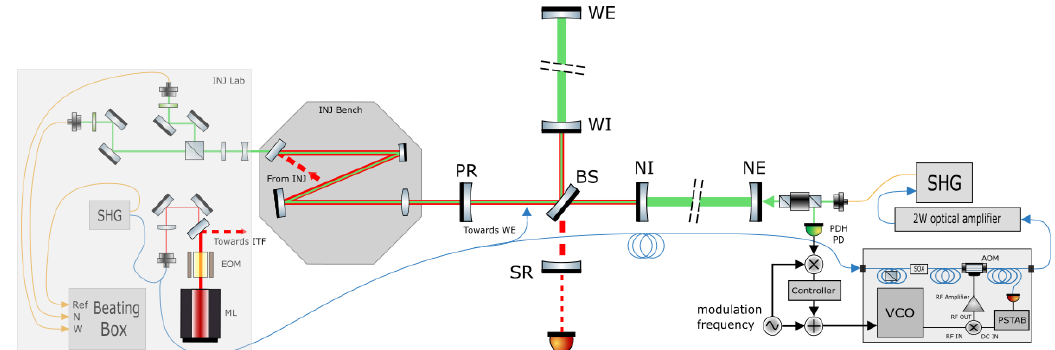
Figure 2. General scheme of the Auxiliary Lasers System implemented in Virgo. The pick-off of the main infrared beam is taken after the corrections of the frequency stabilization, done by acting on the temperature of the crystal of the ML, by applying a stress on this crystal thanks to a piezoelectric transducer and with an EOM at higher frequencies. The beam is then fibered and split into three parts: Two are brought to the end buildings and frequency-doubled in the SHG boxes, the third one, which is the reference beam (indicated as Ref in the beating box), is doubled in the INJ lab. In the north and west end buildings, before being doubled the infrared seed is frequency shifted while passing through a fibered AOM. The control of this frequency shift thanks to the VCO allows us to keep the arms locked with the green light. The transmitted light from the arms is recombined with the reference at the level of the beating